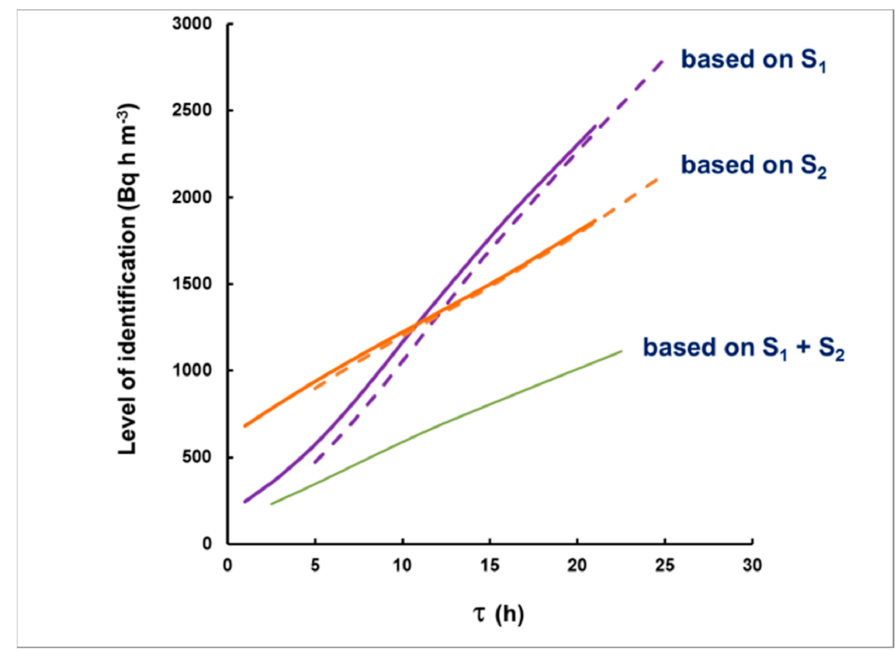
Figure 9. The dependence of the “level of identification” on the delay, when using S 1 (violet), S 2 (orange) or S 1 + S 2 (green). Even for S 1 , the dependence on plume duration is weak (dashed line). The solid lines are for plumes of duration 2 h, and the dashed lines for 10